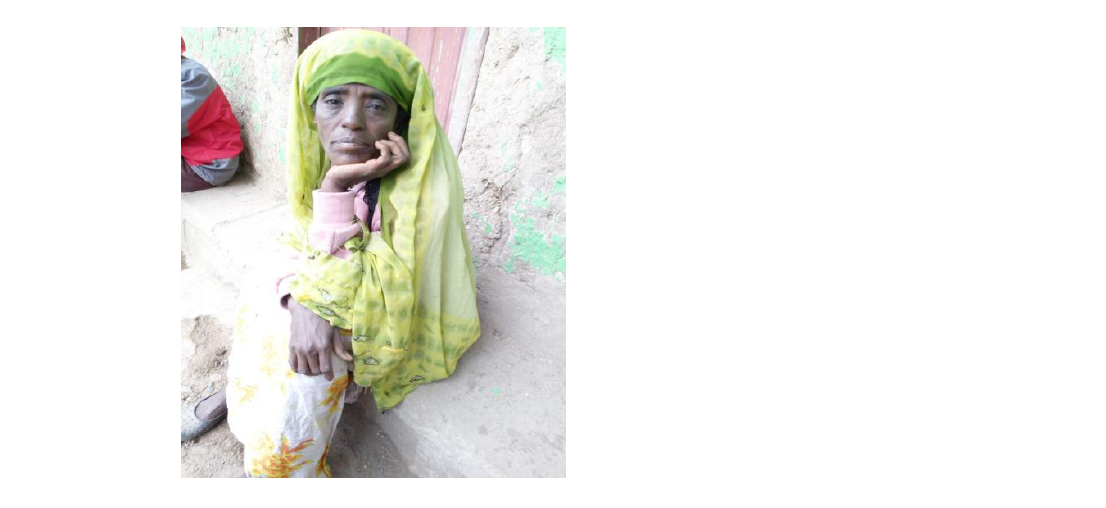
Figure 9. Amina, 27 January 2020, Amudde. Sad, broken, and desperate look. Photo, Author.